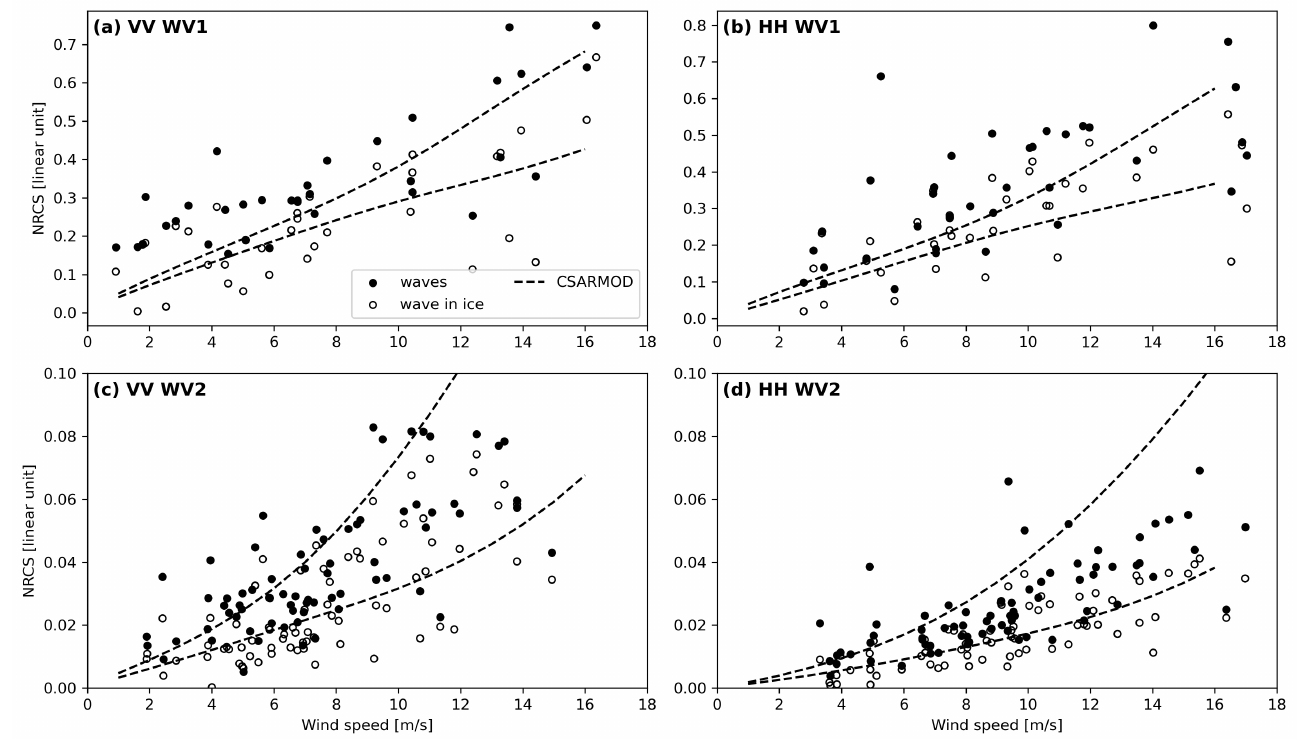
Figure 4. SAR NRCS over the open ocean (solid circle) and the waves in sea ice (empty circle) is plotted against the collocated wind speed for ( a ) VV, WV1; ( b ) HH, WV1; ( c ) VV WV2 and ( d ) HH WV2. The dashed line in each subplot is the CSARMOD NRCS for the given polarization and incidence angle in the wind directions of 0 ◦ (upwind) and 90 ◦